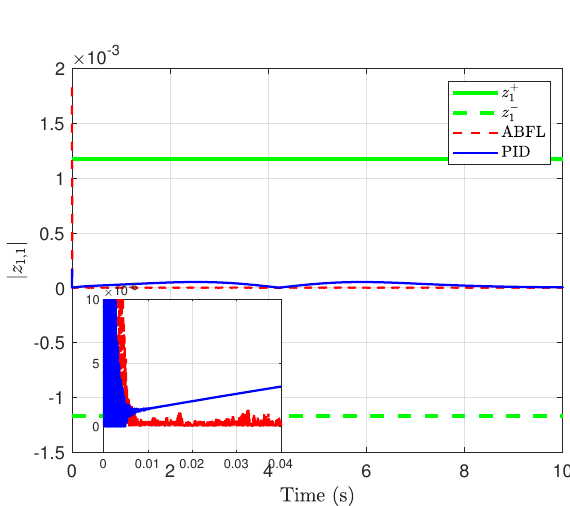
Figure 6. Tracking error for the